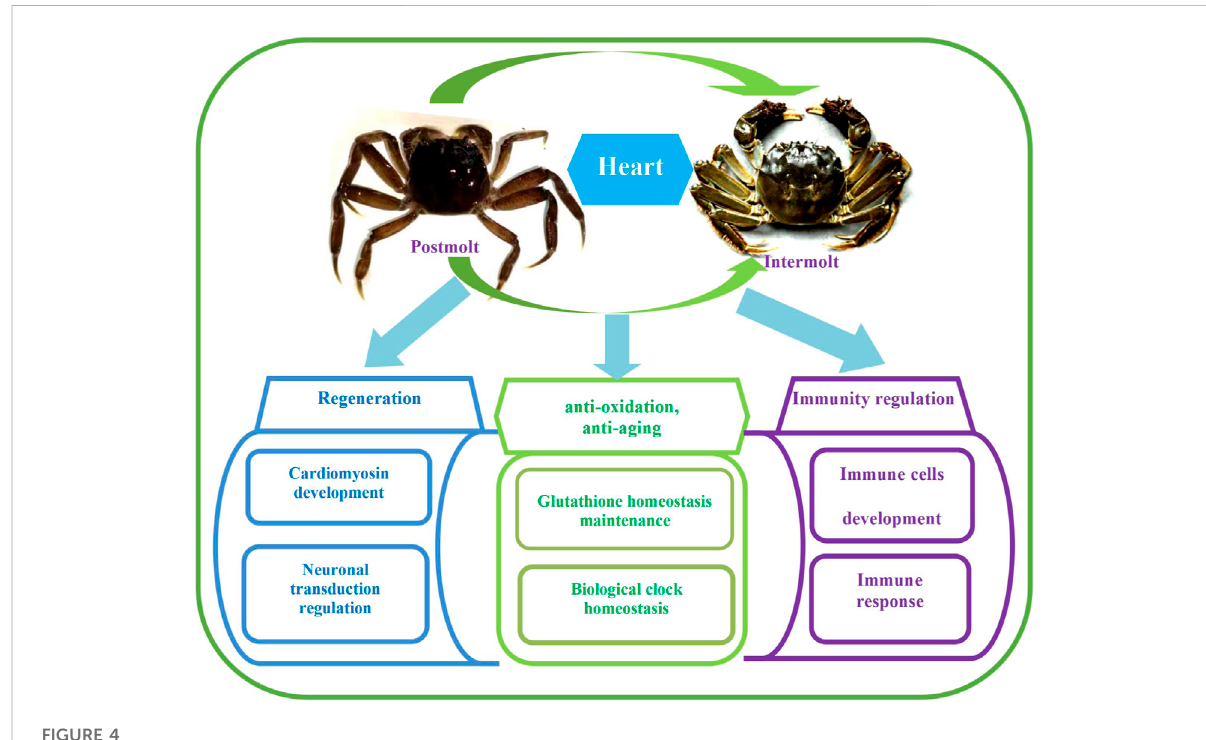
FIGURE 4 Regulatory network in the heart of E. sinensis identi fi ed between the post-molt and inter-molt stages.